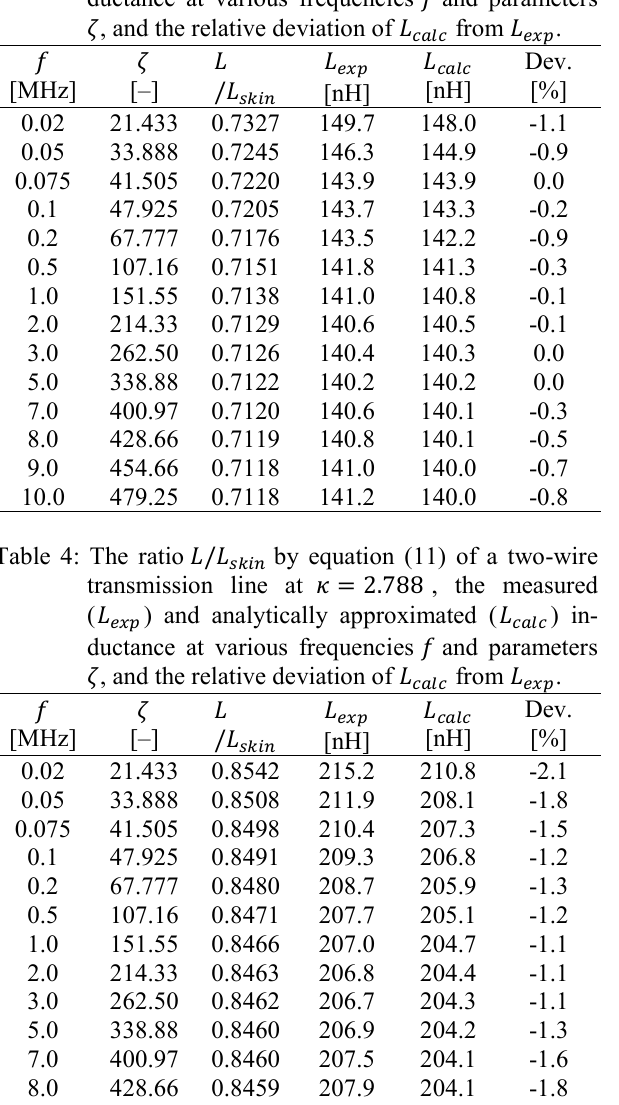
Table 3: The ratio 𝐿/𝐿 𝑠𝑘𝑖𝑛 by equation (11) of a two-wire transmission line at 𝜅 = 2.386 , the measured ( 𝐿 𝑒𝑥𝑝 ) and analytically approximated ( 𝐿 𝑐𝑎𝑙𝑐 ) in- ductance at various frequencies 𝑓 and parameters 𝜁 , and the relative deviation of 𝐿 𝐿 𝑐𝑎𝑙𝑐 from 𝑒𝑥𝑝 .